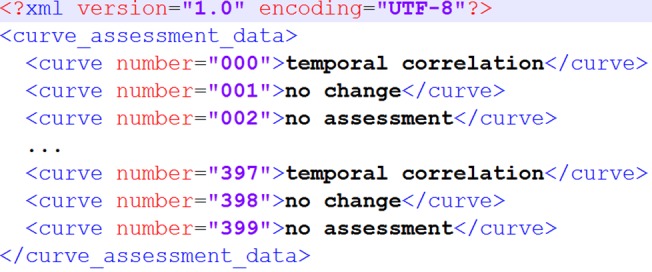
XML structure needed for loading external data into the DOG reutilization tool.